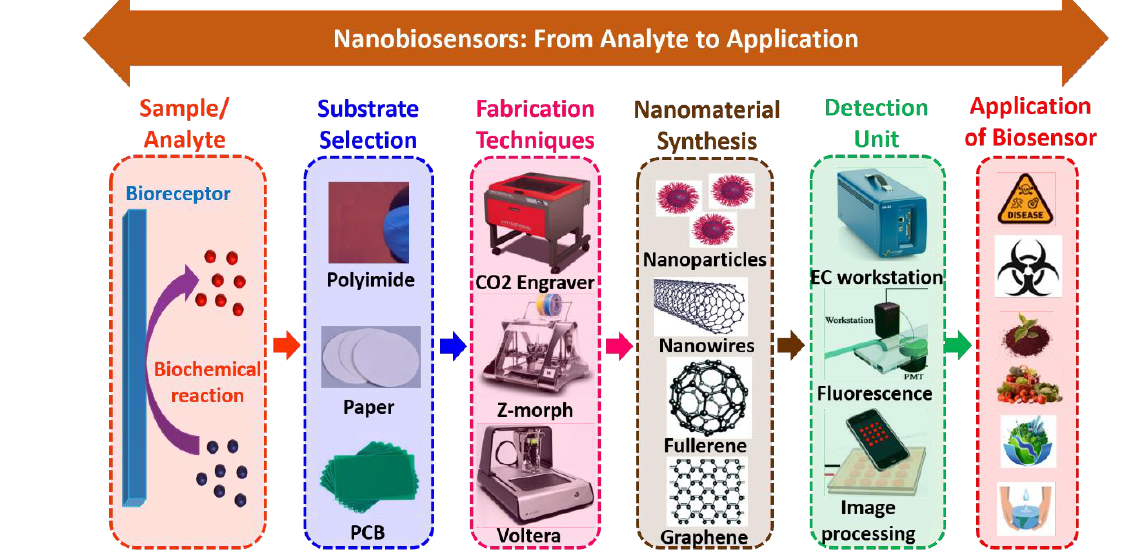
Figure 5. Schematic representation of nanobiosensors, from analyte to application. Table 4. Different types of nanomaterials are used to create nanobiosensors.